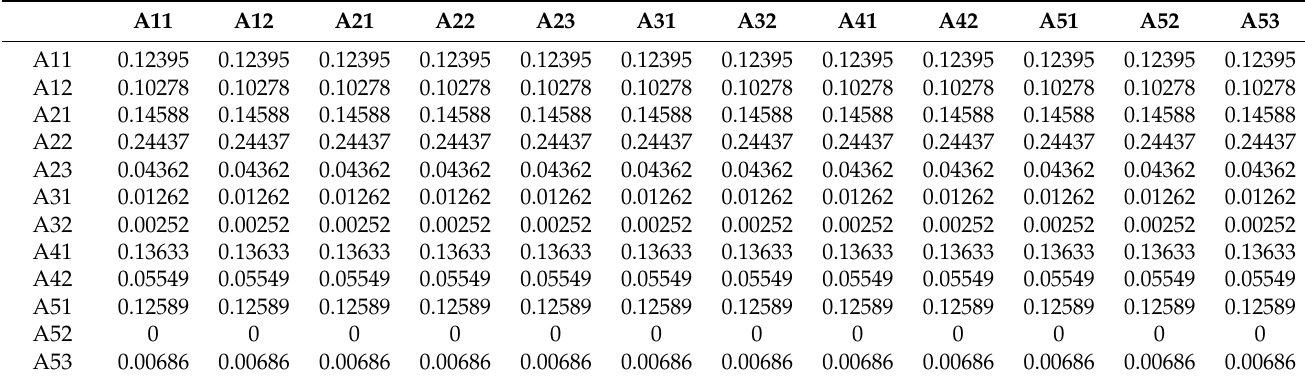
Table 8. The weighted limit hypermatrix.